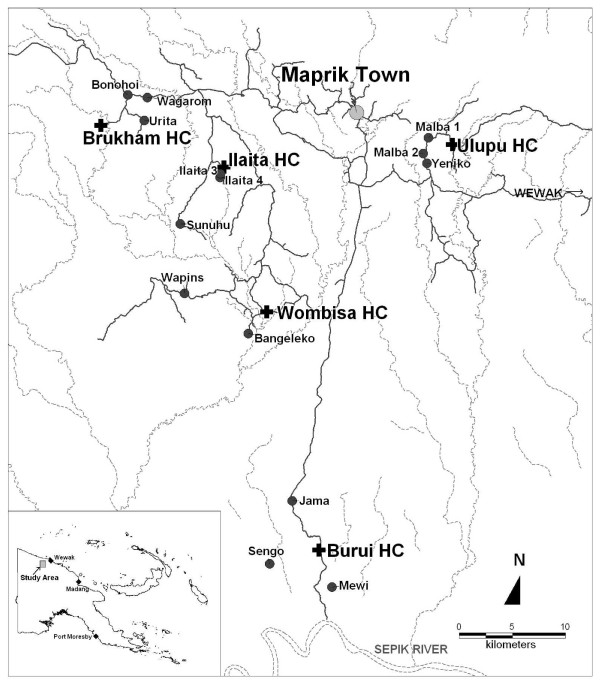
Locations of cross-sectional surveys in vicinity of 5 health centres (HC) in the Middle Sepik Region of Papua New Guinea. Wombisa village and health centre are in the same location.